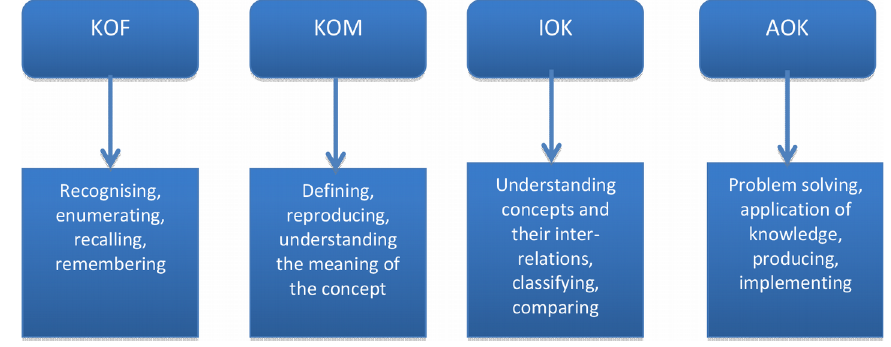
Figure 3. Representation of prior